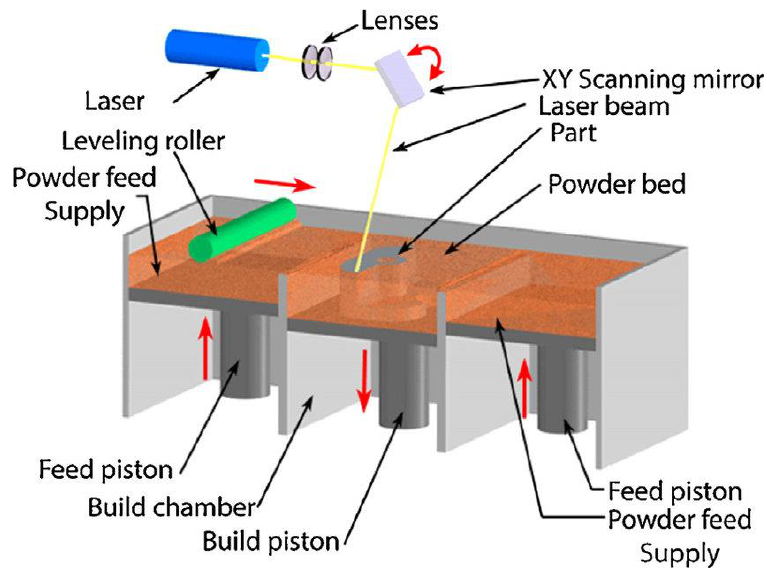
Figure 5. Schematic representation of additive manufacturing techniques [133].